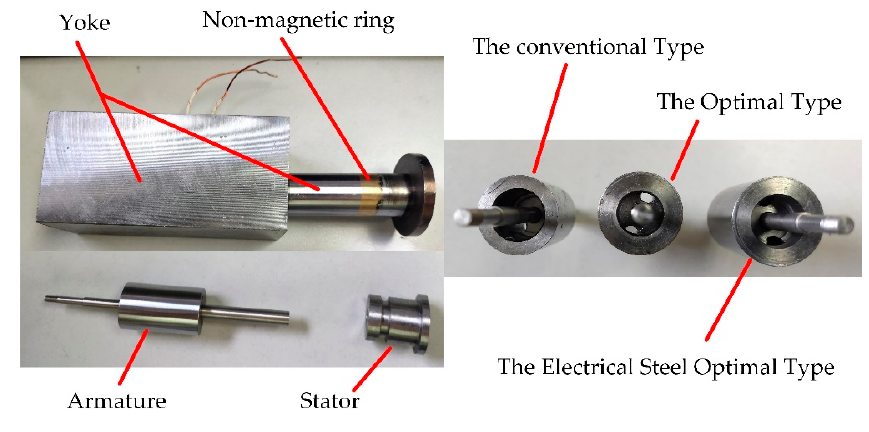
Figure 17. The three types of manufactured LPSs.